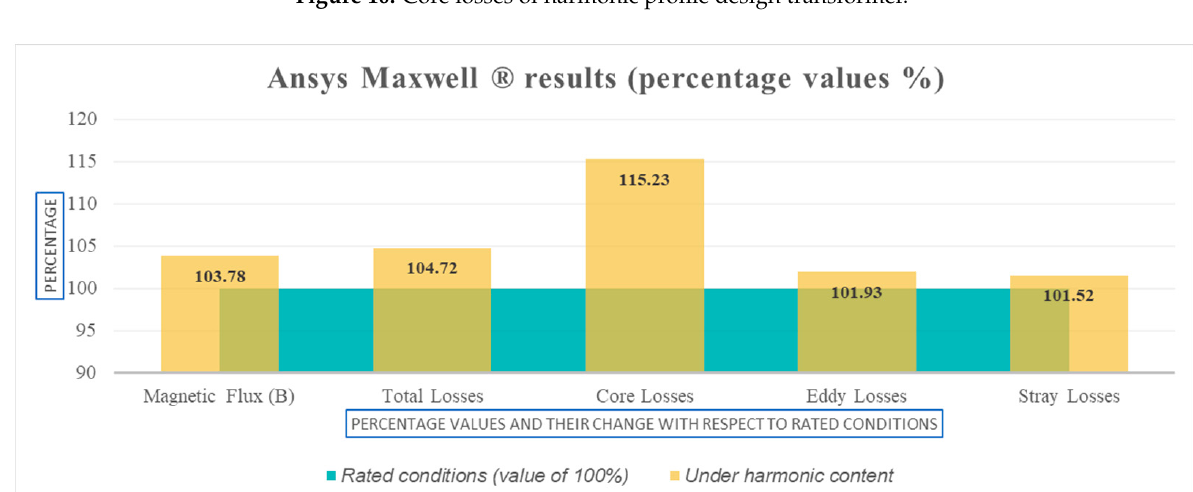
Figure 10. Core losses of harmonic profile design transformer.